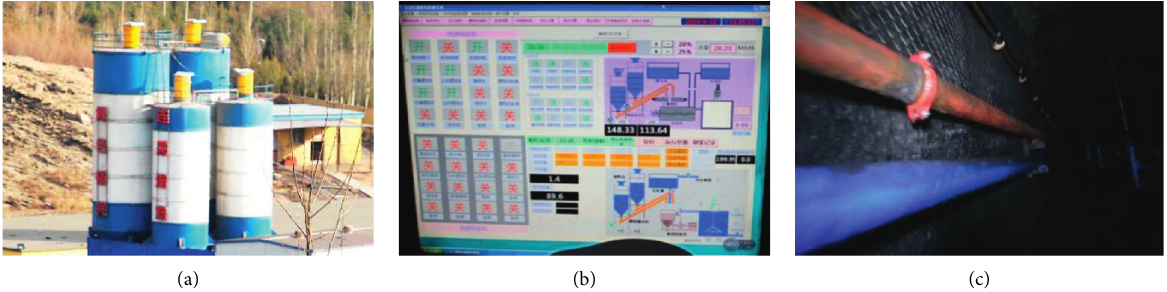
Figure 5: Cement slurry transportation system. (a) Storage bin. (b) Preparation of slurry. (c) Transportation pipeline.